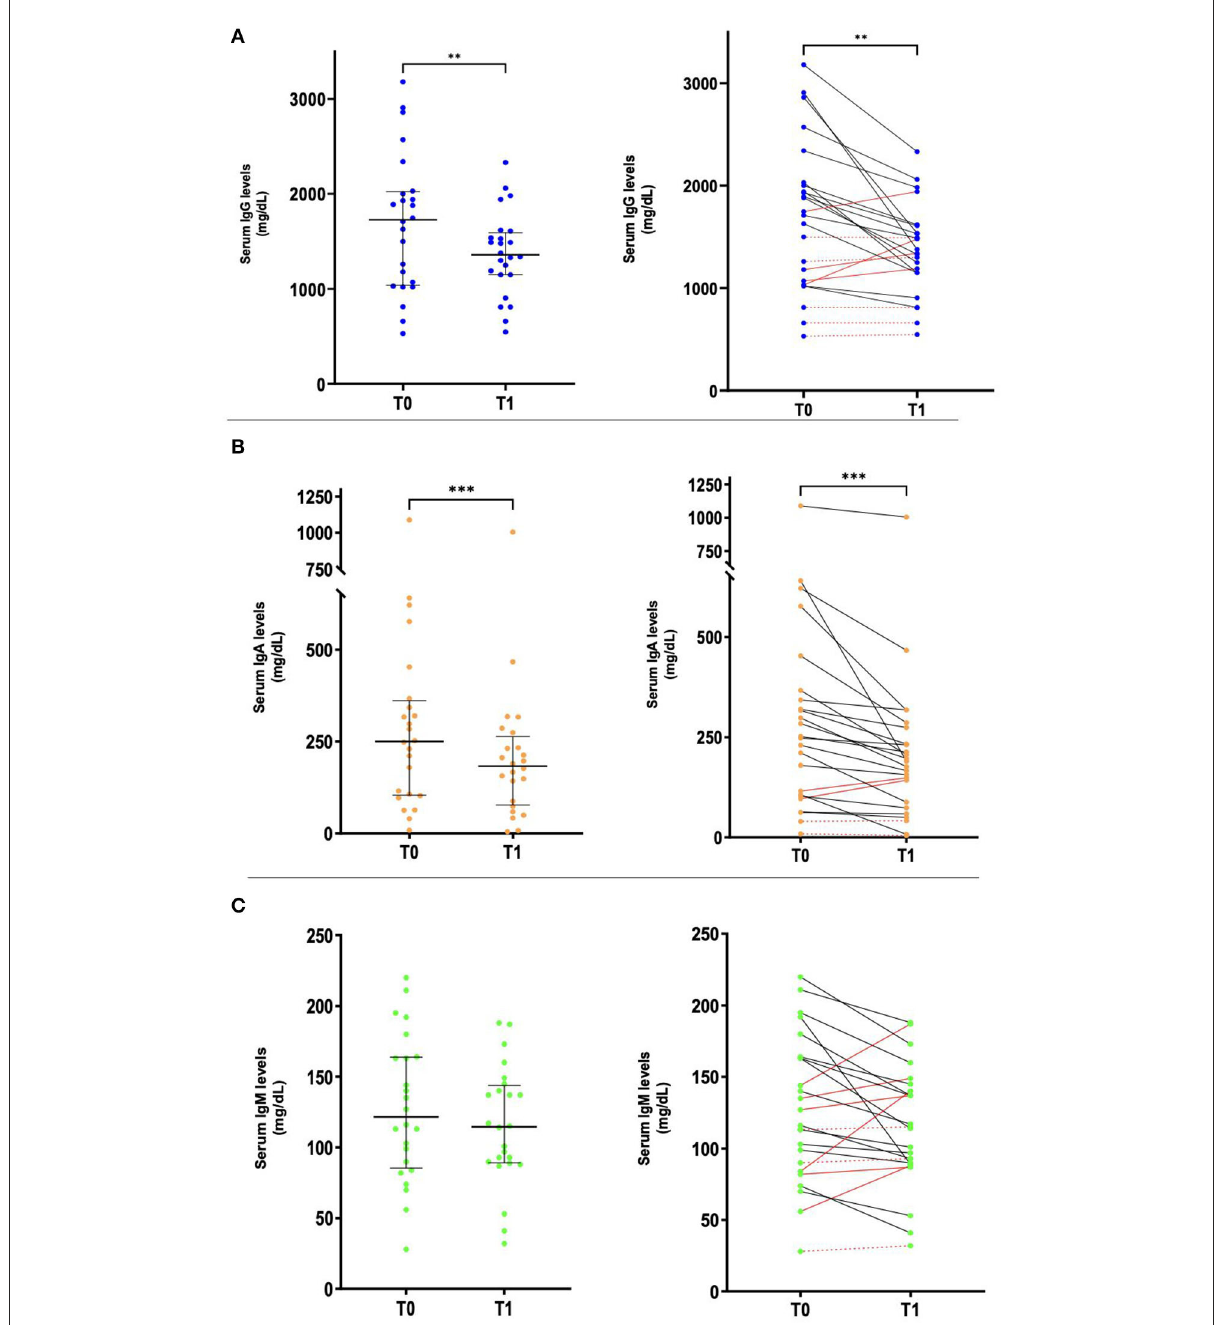
FIGURE2 Variation in serum Ig levels from diagnosis (T0) to follow-up (T1). Left panels: scatter plots showing median (A) IgG, (B) IgA, and (C) IgM levels and IQR. Right panels: before-after comparison of serum (A) IgG; (B) IgA, and (C) IgM levels. Comparison between T0 and T1 was performed using t -test or Mann-Whitney test in case of normal or non-normal distributions, respectively ( ** p < 0.01, *** p < 0.001). In the left panels, black horizontal bars indicate median levels, while vertical lines indicate IQR. In the right panels, black lines indicate a reduction of serum IgG/IgA/IgM levels from T0 to T1, red continuous lines indicate an increase in serum Ig levels from T0 to T1, and red dotted lines indicate patients whose IgG/IgA/IgM levels were stable from T0 to T1. Ig, immunoglobulins; IQR, interquartile